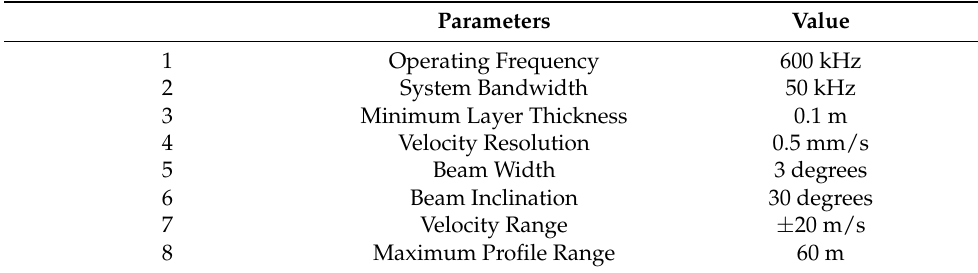
Table 1. The parameters of the experimental platform.